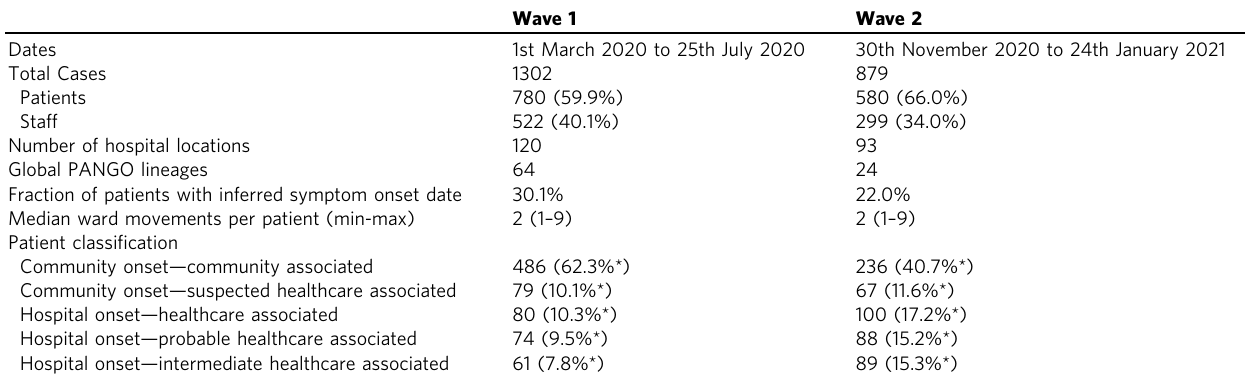
Table 1 Summary of study